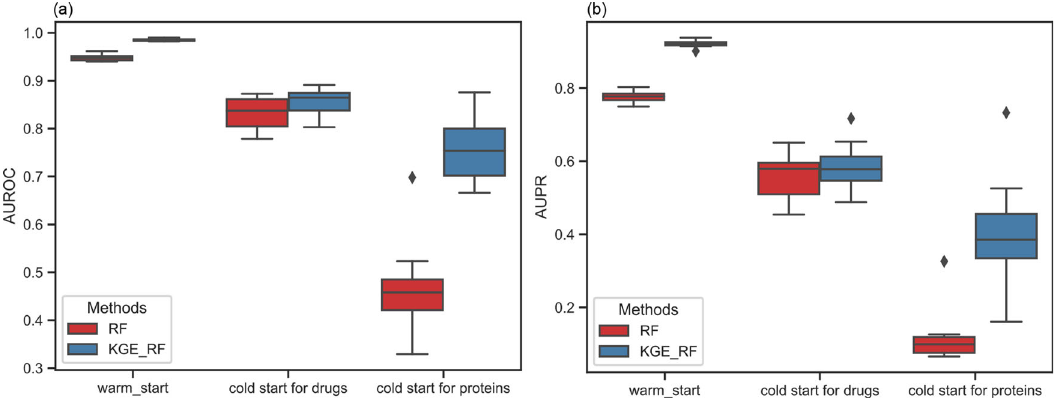
Fig. 5 KGE enables RF to improve predictive performance on the Yamanishi_08 ’ s dataset under three sample scenarios. KGE_RF uses KGE and drug fi ngerprints and protein descriptors as the input features and uses RF to build the classi fi ers. N = 10 independent experiments. Box plots show the median as the center lines, upper and lower quartiles as box limits, whiskers as maximum and minimum values, and dots